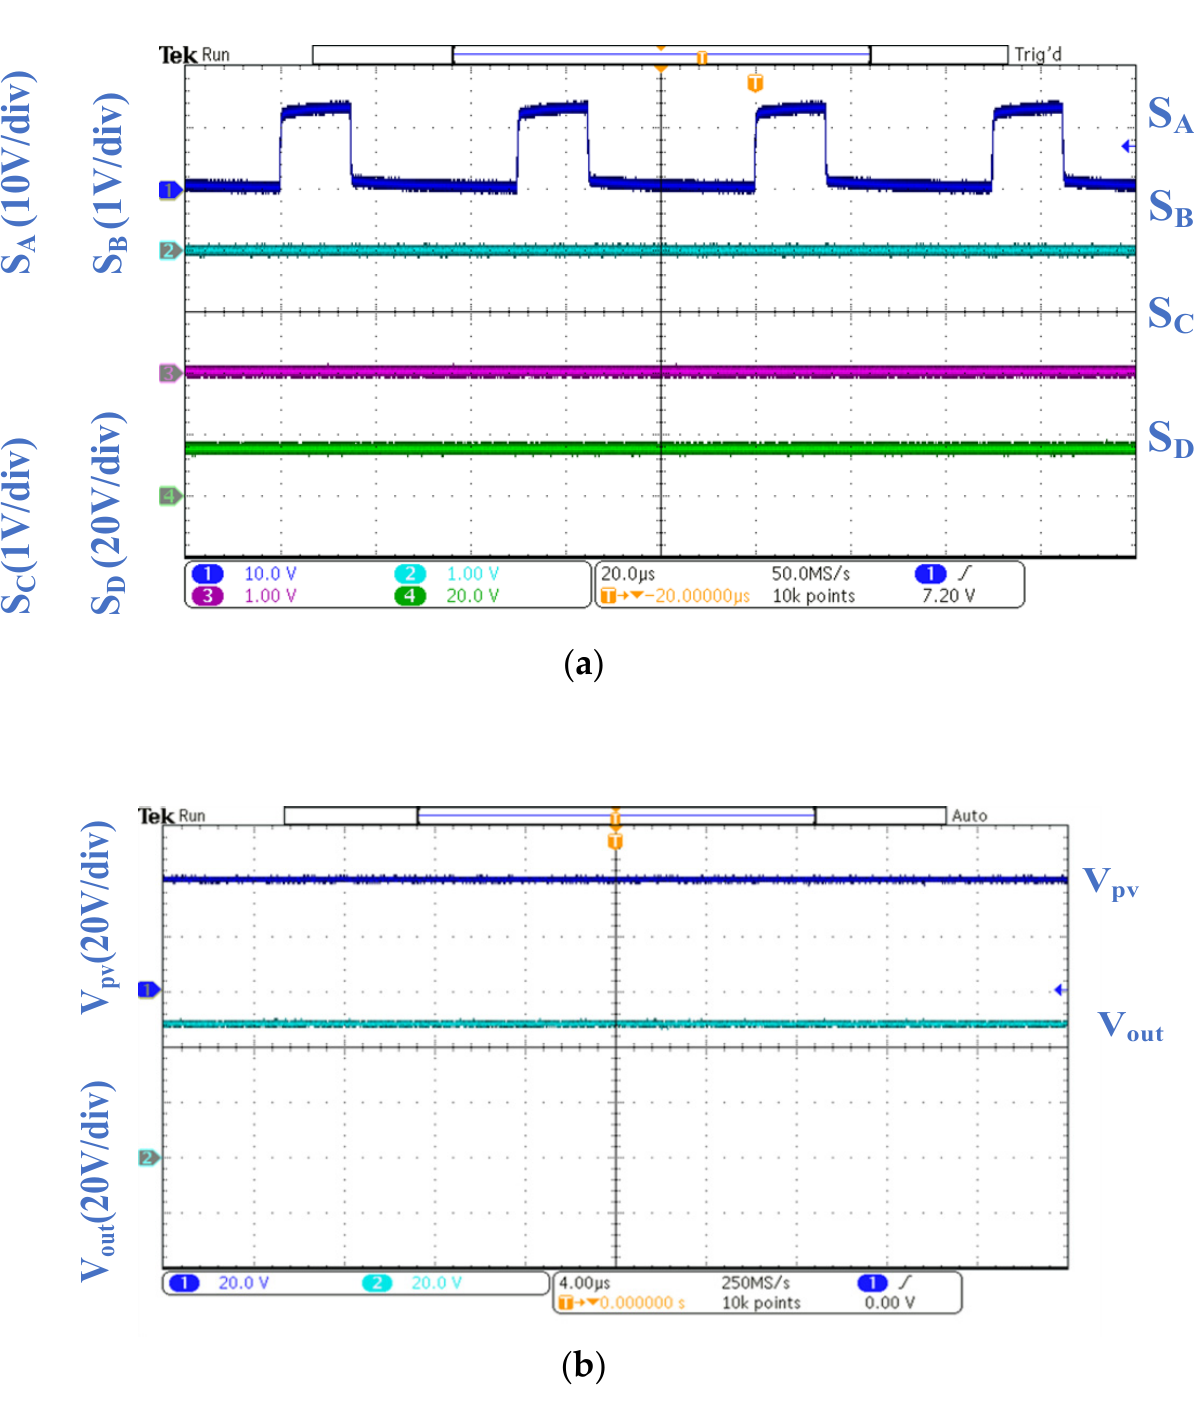
Figure 14. Experimental waveforms of the proposed IIABB converter for V pv of 40 V and N = 3: ( a ) experimental waveforms of switches S A and S D are operating; S B and S C are not operating; and ( b ) waveforms of V pv = 40 V and output voltage V out = 48 V via an intelligent control strategy and HC MPPT algorithm at a duty cycle of 0.3.